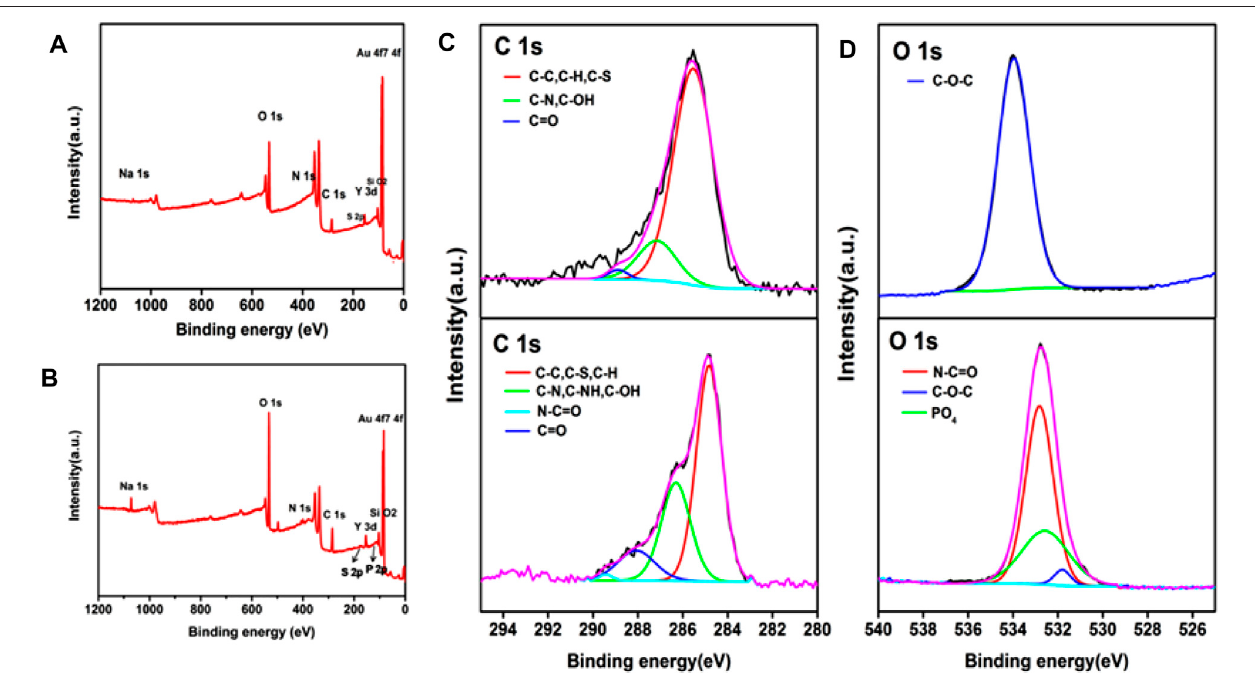
FIGURE 4 | Differential pulse voltammetric (DPV) response for UCNPs@SiO 2 @Azo/Au electrode incubated with different concentrations of ctDNA in 0.1 M pH 7.4 phosphate buffer; pulse period, 0.2 s; and amplitude, 50 mV.